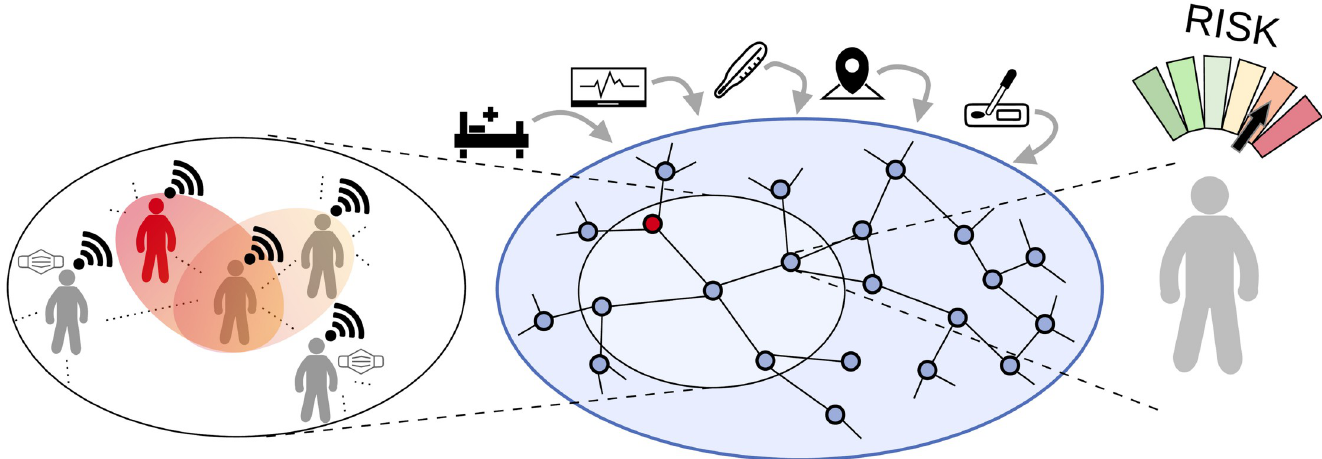
Fig 1. Schematic of the personalized risk assessment platform. Proximity-tracking data from mobile devices is used to assemble a contact network, in which nodes represent individuals and edges represent close contacts between individuals. An epidemiological model defined on the contact network is then fused with diverse health data, including diagnostic tests, hospitalization status, and possibly data such as body temperature readings. The model spreads risk of infectiousness from a positive individual (red) to others, taking into account knowledge about disease progression, the time and duration of contacts, and the use of personal protective equipment (PPE), among other factors. The result of the network DA is an assessment of individual risks, for example, of being infectious, which then can be used to target contact interventions.